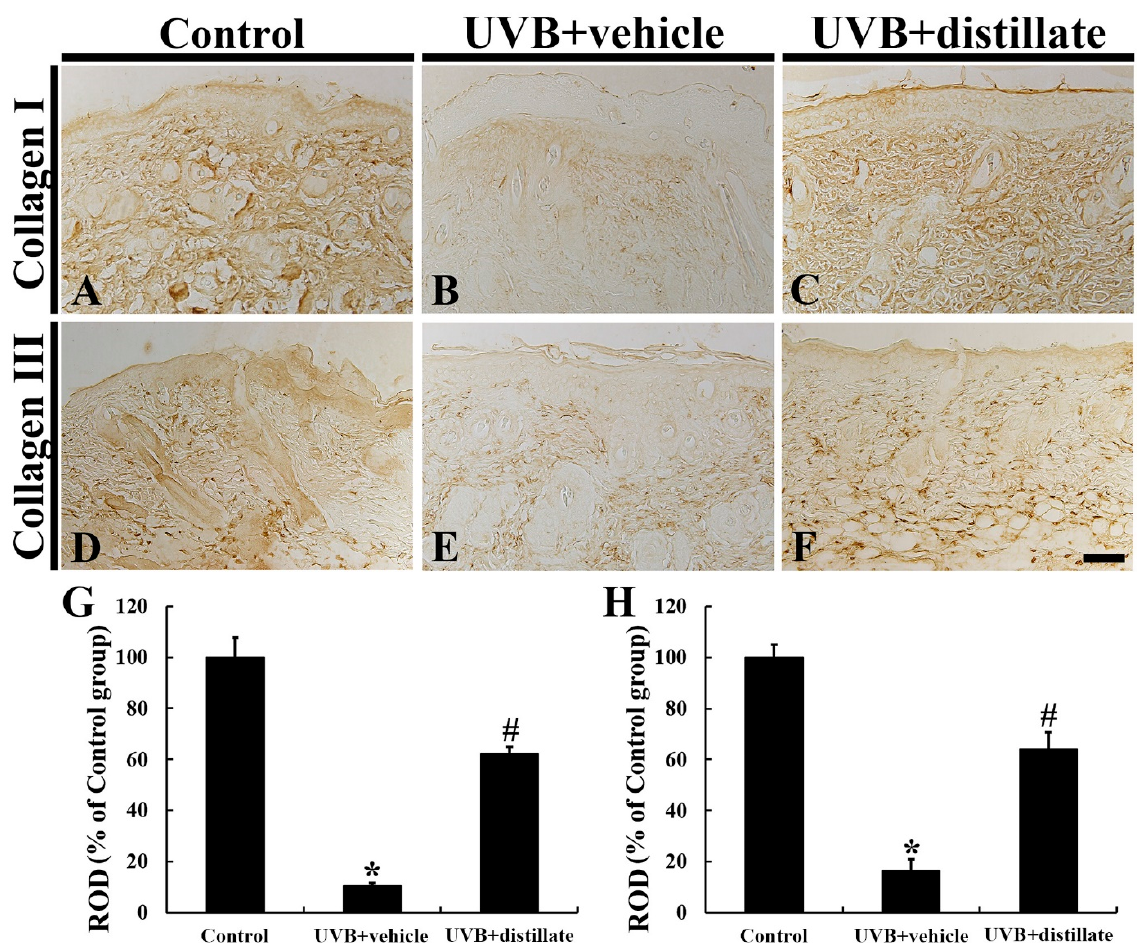
Figure 4. Collagen I ( A – C ) and III ( D – F ) immunohistochemistry in the dorsal skin of the control ( A , D ), UVB + vehicle ( B , E ), and UVB + distillate ( C , F ) groups at 5 days after UVB exposure. In the UVB + vehicle group, collagen I and III immunoreactivity in the dermis was significantly decreased compared with that in the control group. However, collagen I and III immunoreactivity in the UVB + distillate group was markedly increased compared with that in the UVB + vehicle group. Scale bar = 100 μ m. ( G , H ) Relative optical density (ROD) of collagen I ( G ) and III ( H ) immunoreactivity in the dorsal skin as percentage of the control group. The data represent mean ± standard errors of means ( n = 10/group, * p < 0.05 vs. control group; # p < 0.05 vs. UVB + vehicle group).